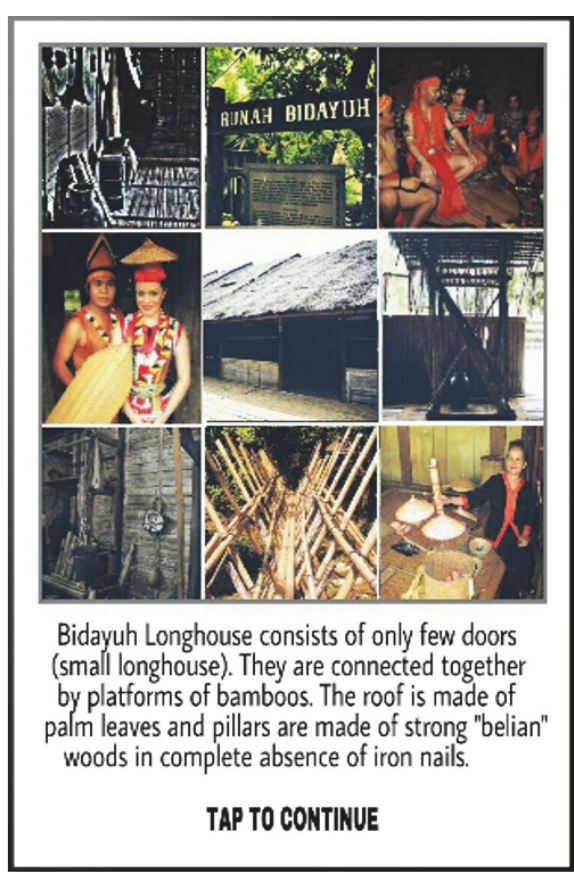
Figure 8: Information about the Bidayuh Longhouse.